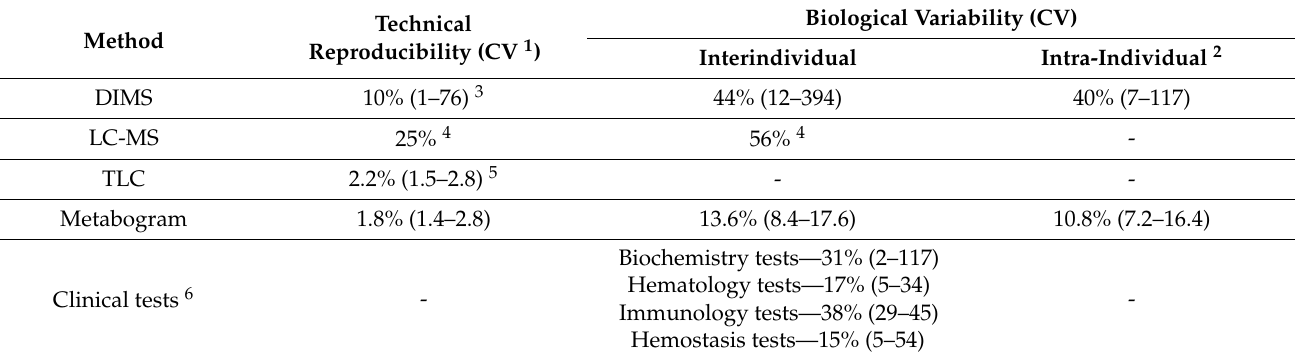
Table 2. Comparison of technical reproducibility and biological variability between mass spectromet- ric metabogram, direct mass spectrometry, liquid chromatography combined with mass spectrometry, and clinical